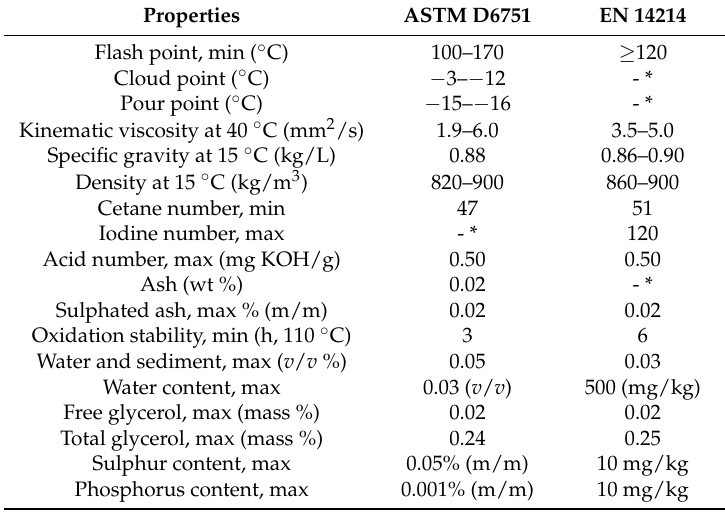
Table 2. Properties of biodiesel [4,9,15,17,32,38,40,41].